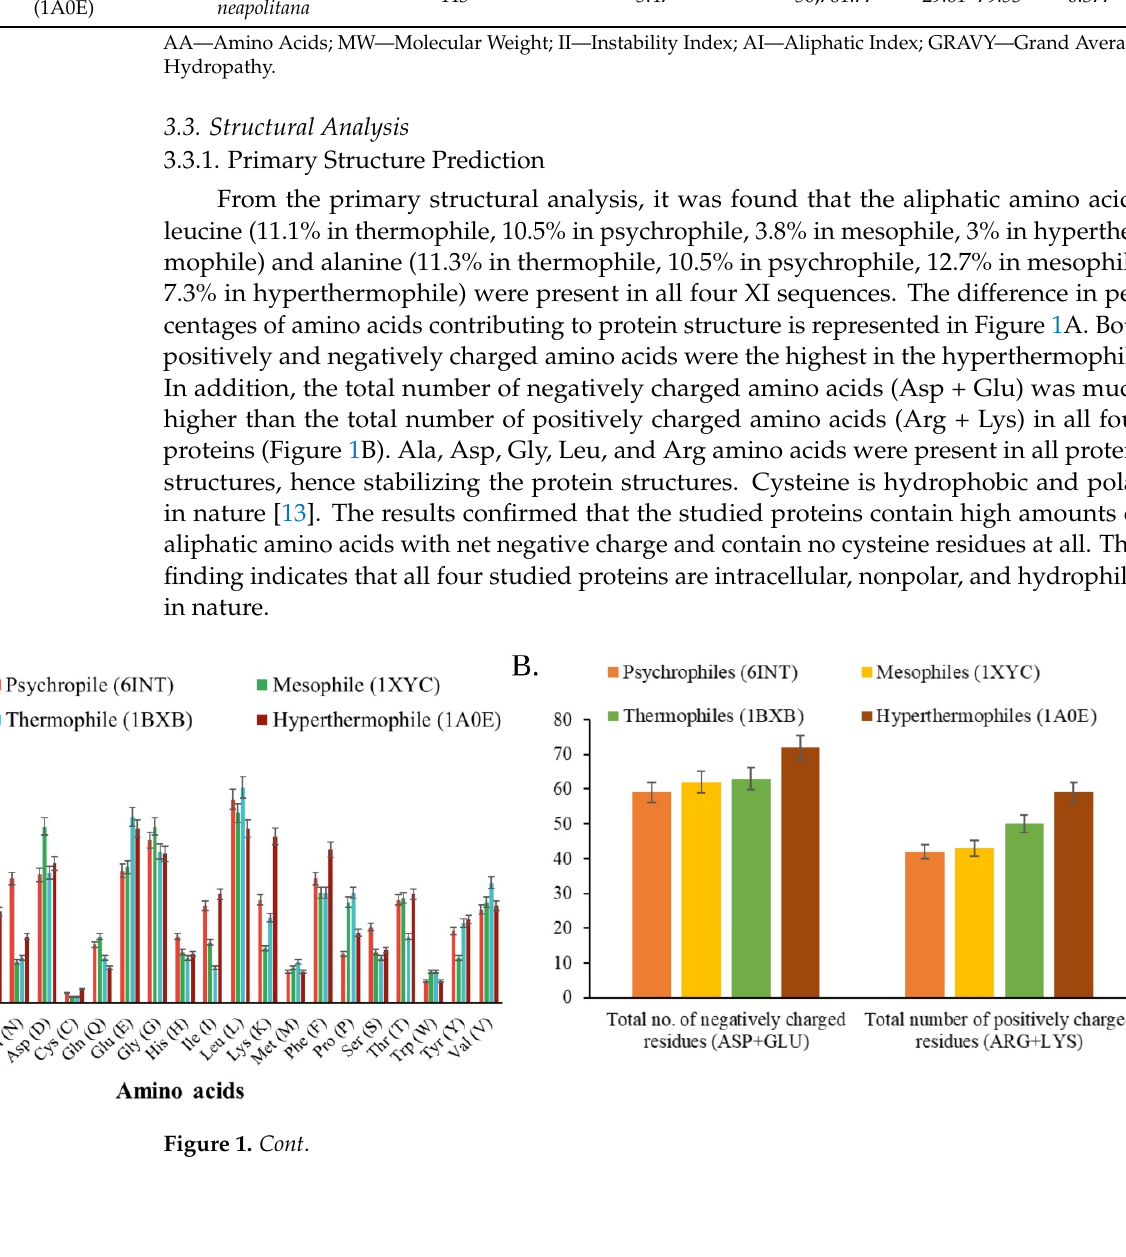
Figure 1. Diagrammatic representation of comparison of the primary, secondary, and tertiary struc ‐ ture between xylose isomerase from four different classes (psychrophile, mesophile, thermophile, and hyperthermophile). ( A ) percentages of amino acids contributing to structural configuration, ( B ) number of positively charged (ARG + LYS) and negatively charged (ASP + GLU) amino acid resi ‐ dues, ( C ) different kinds of secondary structures, ( D ) salt bridge composition along with mean dis ‐ tances. 3.3.2. Secondary Structure Prediction In the computational study, the secondary structures of the four bacterial XIs were predicted using the web ‐ based server SOPMA [16]. All the proteins were rich in α‐ helices (50.68%, 46.89%, 47.03%, and 50.34%, respectively, for the psychrophile, mesophile, ther ‐ mophile, and hyperthermophile) followed by random coils (32.88%, 35.23%, 36.95%, and 32.05% for the psychrophile, mesophile, thermophile, and hyperthermophile, respec ‐ tively). The percentage of the extended strand was 10.50%, 12.95%, 11.37%, and 10.84% for the psychrophile, mesophile, thermophile, and hyperthermophile, respectively (Fig ‐ ure 1C). This result predicts that the selected proteins are mainly rich in α‐ helices and random coils with beta strands having the least presence. A higher percentage of amino acids forming α‐ helices indicates the temperature stability of any enzyme [34]. On the other hand, a higher percentage of random coils denotes that the enzyme is functionally active [13]. According to this study, thermophilic ‐ origin XI was found to be most func ‐ tionally active, whereas psychrophilic ‐ origin XI had the most α‐ helices, i.e., the best tem ‐ perature stability [34–36].